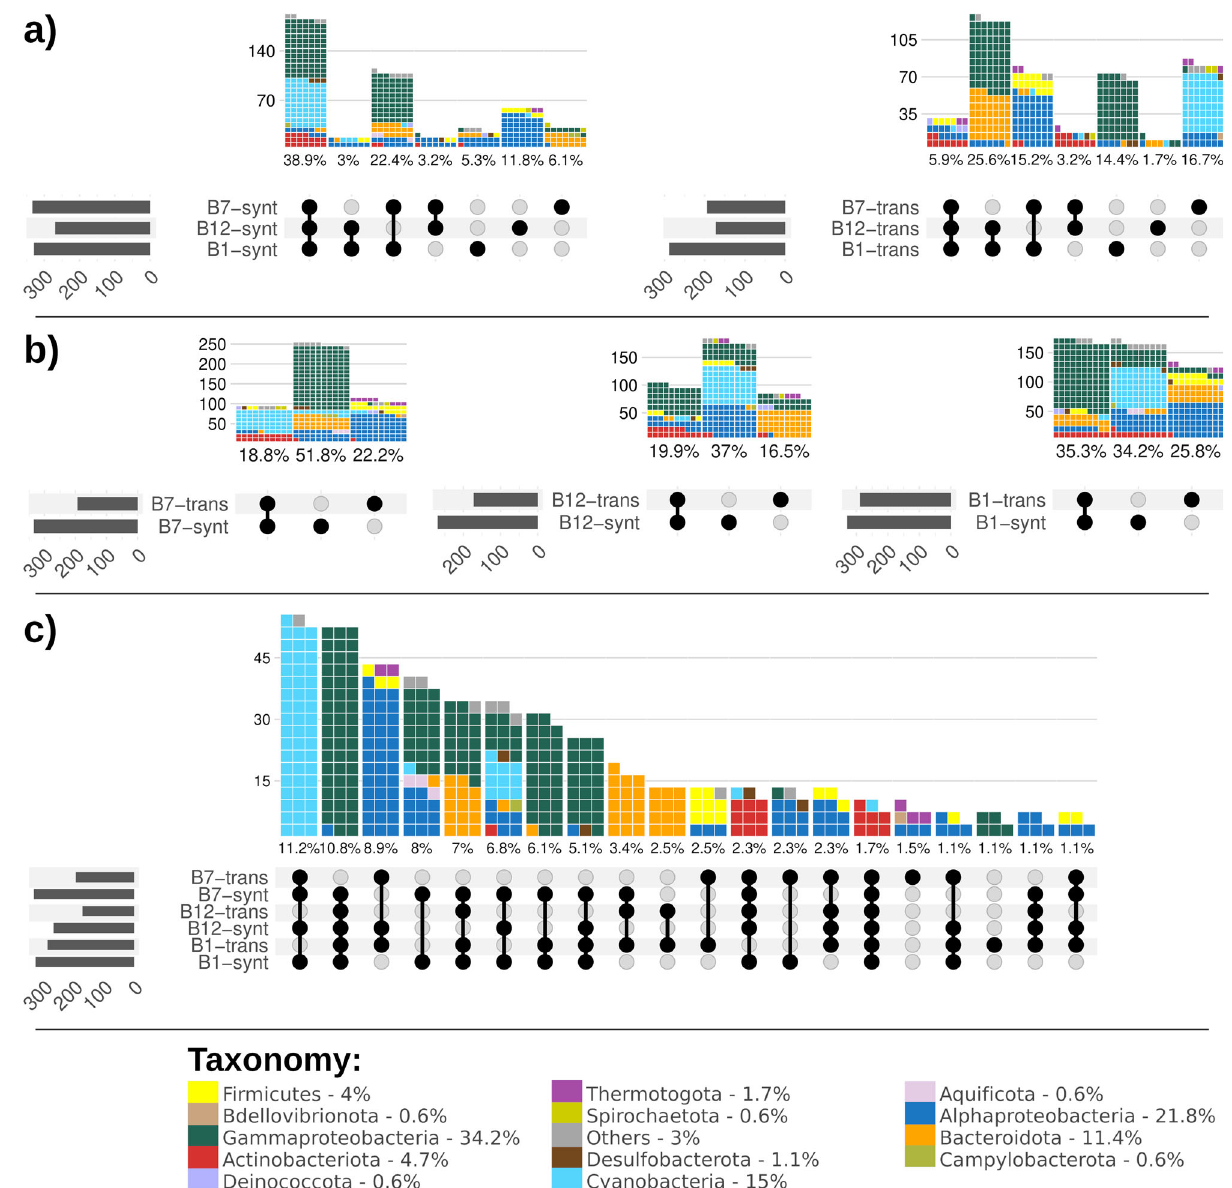
Fig. 3 Different genomic con fi gurations of traits responsible for the biosynthesis and transport of vitamins B 1 , B 12 , and B 7 . a Capabilities to produce or transport these vitamins, b different con fi gurations to either produce and/or transport each of these vitamins and c the most abundant con fi gurations to produce and/or transport these vitamins across genomes; the remaining combinations are shown in Supplementary Fig. 8a. Overall, the horizontal bar chart indicates the total number of genomes for each trait, the dark connected dots indicate the different con fi gurations of traits and the waf fl e bar chart indicates the number (and percentage) of genomes provided with such a con fi guration; each piece of a waf fl e bar represents a genome and it is coloured according to the